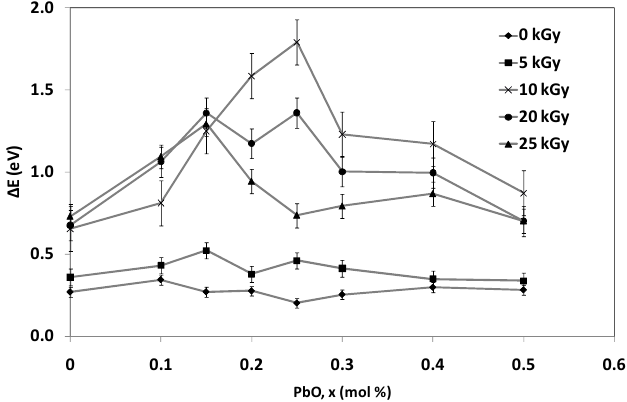
Figure 9. Variation Urbach energy, Δ E of (TeO transition with x = 0%–0.5% mol; y = 0.7% mol at various irradiation exposure. The lines represent the